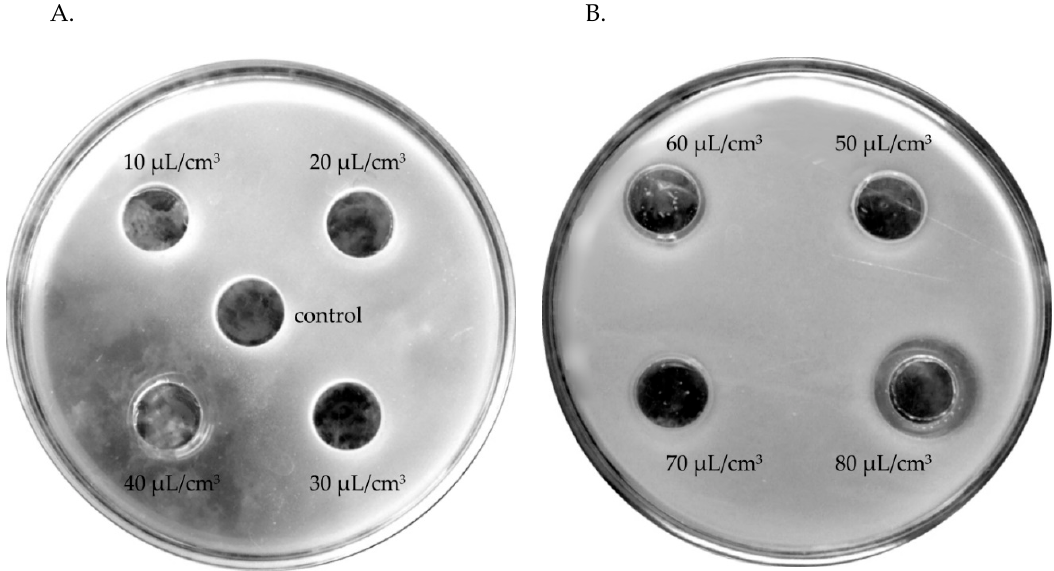
Figure 3. Zones of growth inhibition of a Bacillus cereus isolate in the presence of tested concentrations (10–80 µ L / cm 3 ) of lavender oils: ( A ) ETJA, 40 µ L / cm 3 ; ( B ) Crimean lavender oil, 80 µ L / cm 3 . At lower concentrations (10–40 µ L / cm 3 ), lavender oils manifested neutral e ff ects (Figure 4) or, as in the case of Crimean lavender oil, stimulated bacterial growth (Figure